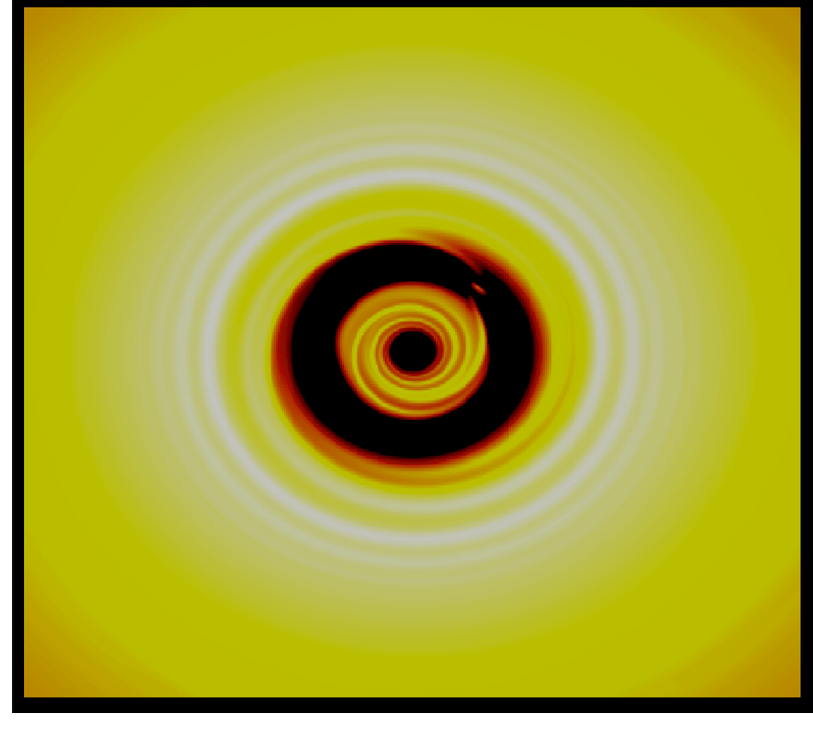
Figure 7. Image from a simulation of a planetary-mass body embedded in a circumstellar disc. For planets that are sufficiently massive, the planet can open a gap in the gas disc and drives waves into the surrounding disc. The planet then migrates inwards with the surrounding disc and can be stranded in a close orbit, forming what is called a ‘hot’